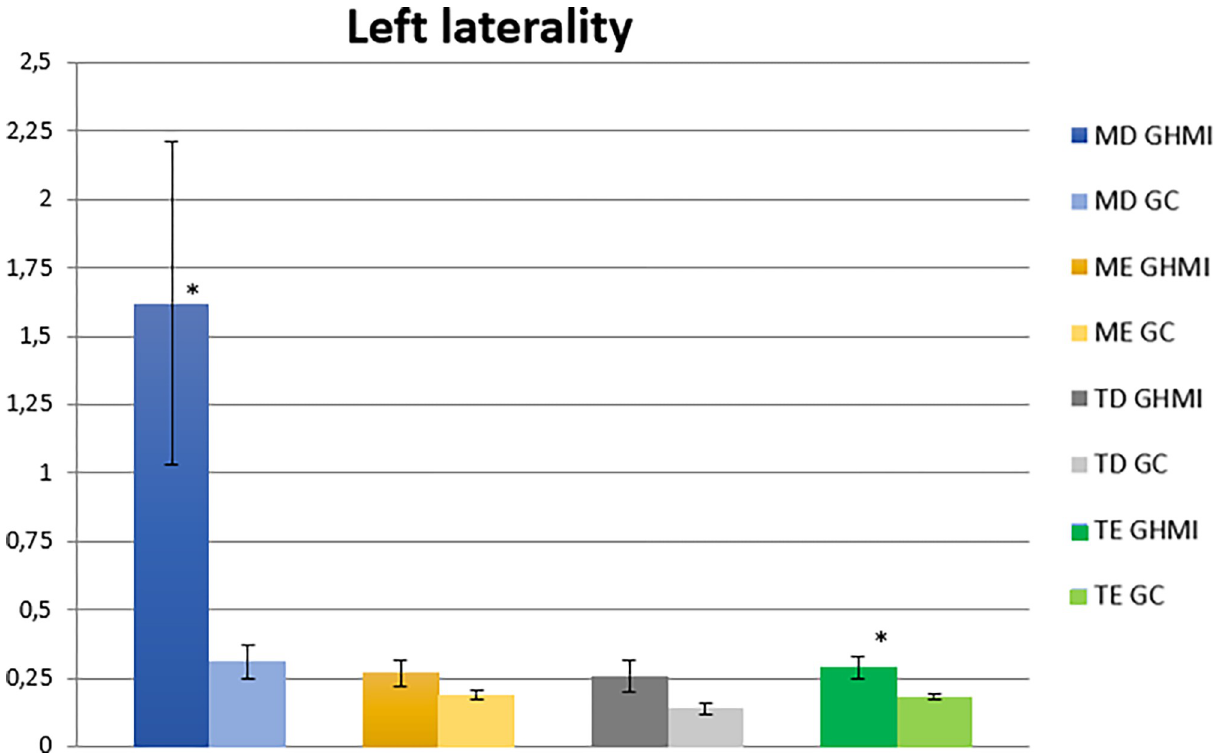
were evaluated, in the following postural conditions (Table 9): mandibular rest, maximum protrusion with dental contact, maximum right and left laterality with dental contact, and tooth clenching in maximum voluntary contraction with Parafilm M 1 . The latter condition was used for the normalization of all these data. In the analysis of mandibular rest, the left masseter, right and left temporal muscles had higher values for electromyographic activities in the group with MIH (MIHG). This fact